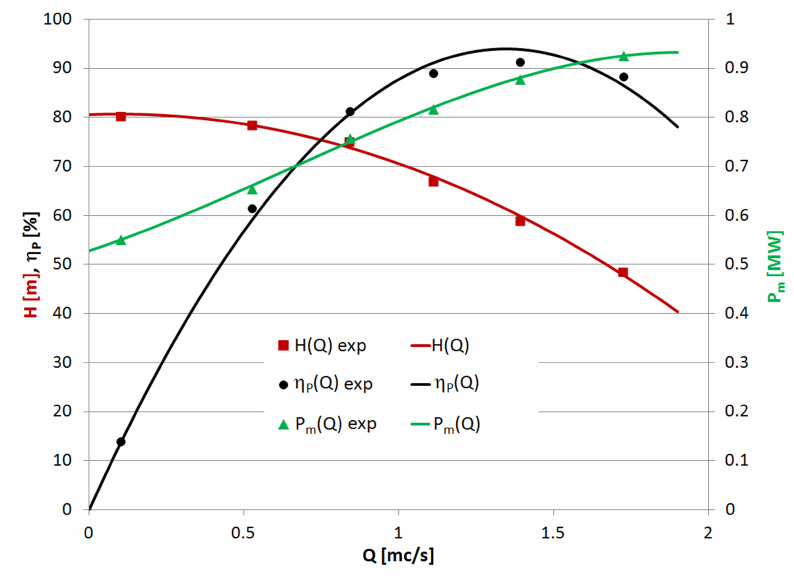
, (cid:78) ) and the polynomial (cid:32)